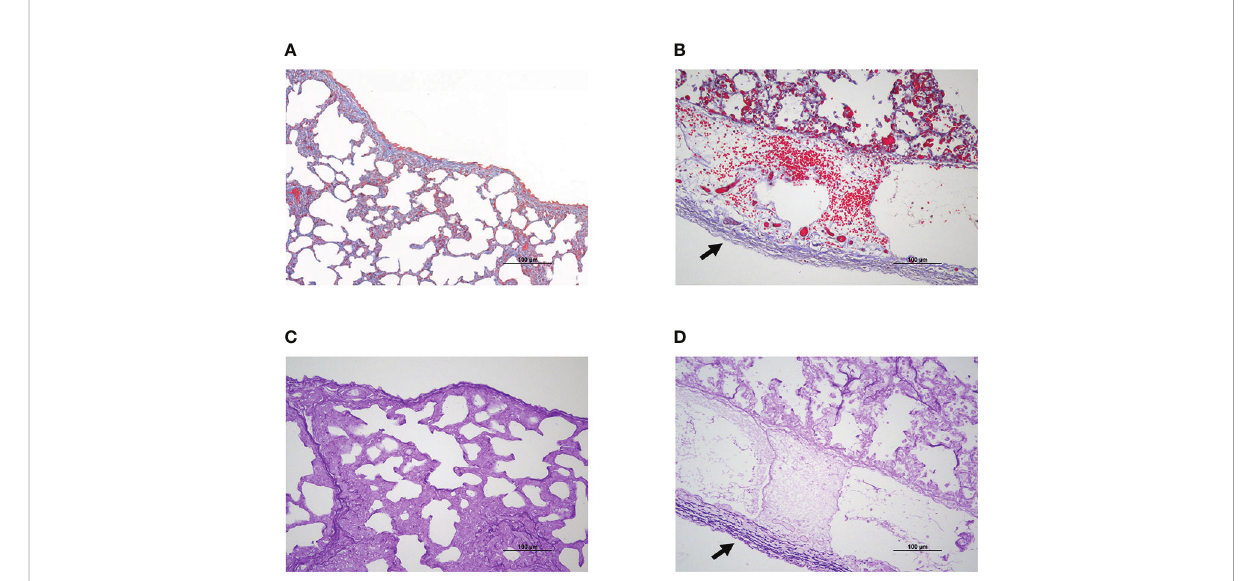
FIGURE 2 Pleural thickening was related to collagen fi ber and elastic fi ber deposition during SH0165 infection. (A, B) Collagen fi ber increased and enriched on pleura after SH0165 infection. Collagen fi ber was indicated as blue through Masson ’ s Trichrome staining. (A) Control group. (B) SH0165 infection group. The increase of collagen fi ber following SH0165 infection was highlighted by black arrow in (B) . (C, D) Elastic fi ber elevated and accumulated on pleura after SH0165 infection. The elastic fi ber was shown as deep purple according to Modi fi ed Gomori ’ s aldehyde-fuchsin staining. (C) Control group. (D) SH0165 infection group. The enrichment of elastic fi ber after SH0165 infection was indicated with black arrow in (D) . Scale bar: 100 m